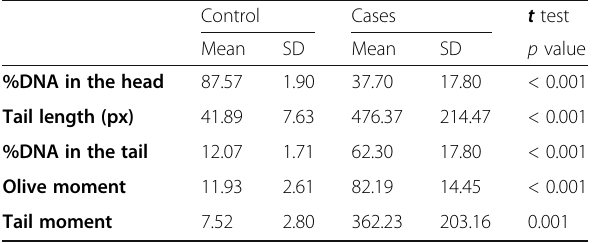
Table 3 Comparison of degree of DNA damage in OP poisoning cases